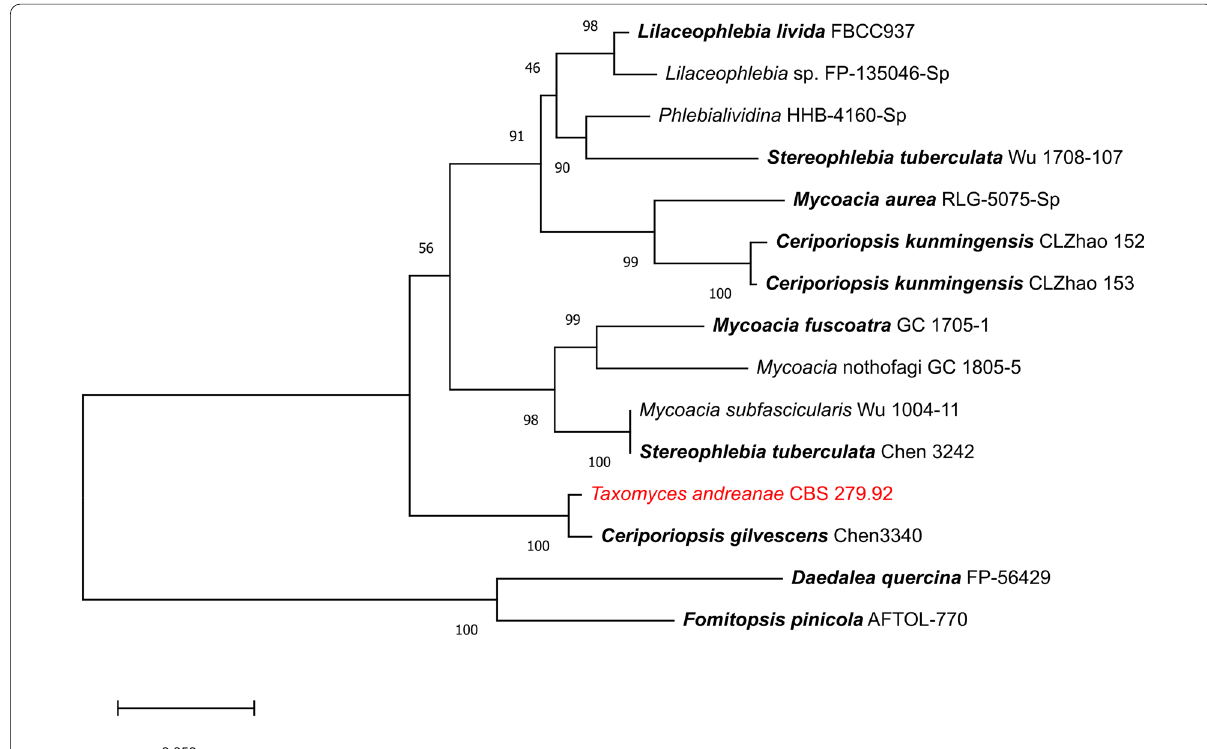
Fig. 2 Phylogram of Taxomyces andreanae and phlebioid species inferred from ML analyses using the combined ITS dataset. Sequences are listed in the Additional file 1. The type species of the respective genera are printed in bold, even though most sequences are not derived from type or epitype